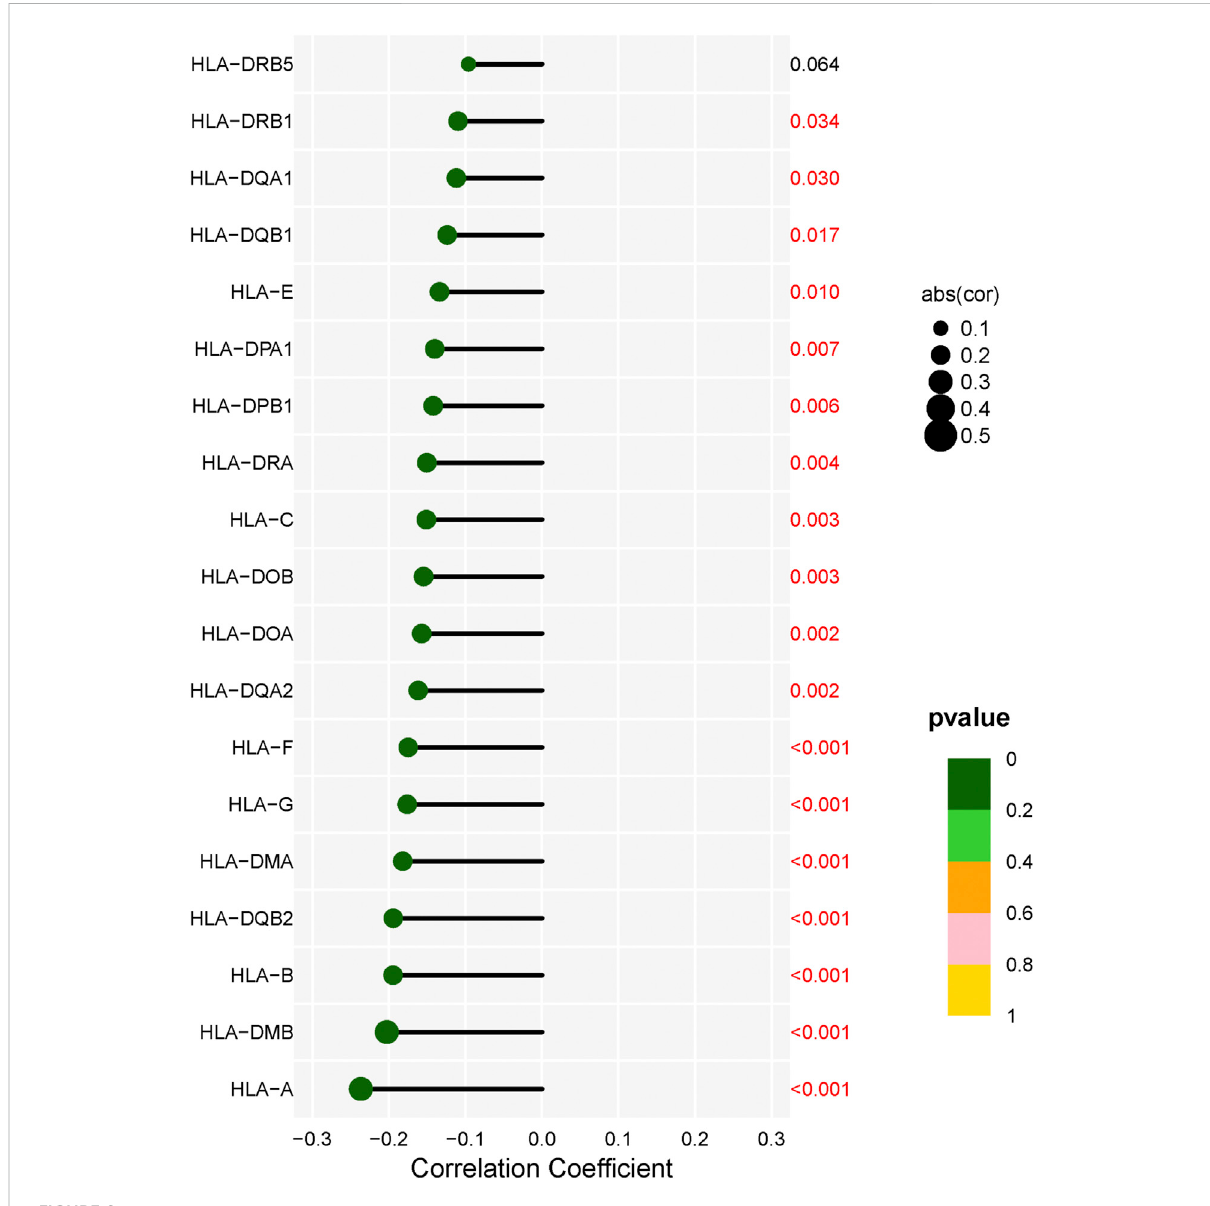
FIGURE 9 Correlation analysis of LECT2 expression with 19 HLA